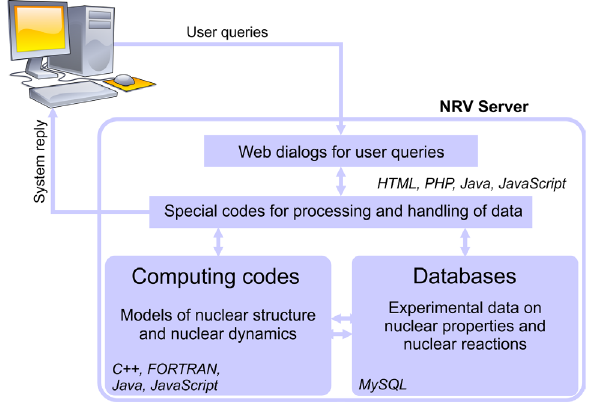
Figure 1. The functioning scheme of the NRV knowledge